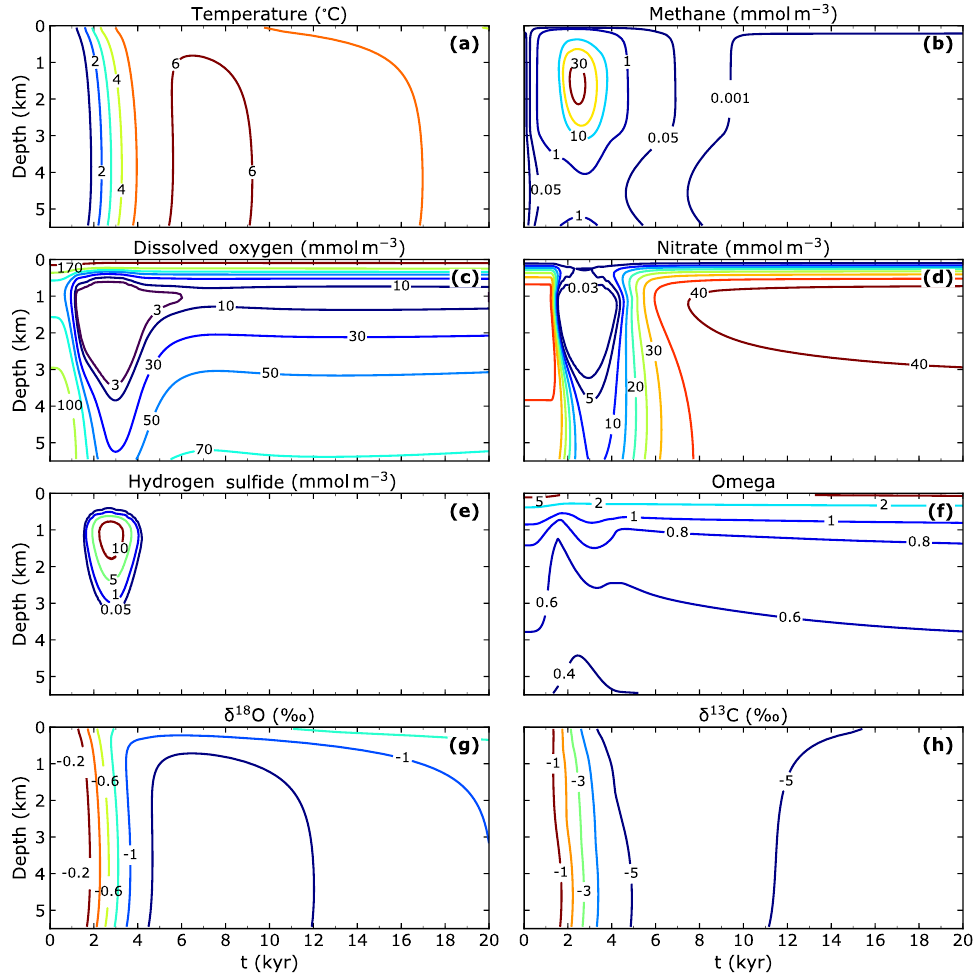
Figure 11. LL ocean property results as functions of water depth and time for a 20000-year simulation with a methane input of 6000GtC over a timescale of 3000 years, all of which dissolves in the ocean. (a) Temperature anomaly, (b) methane concentration, (c) dissolved oxygen concentration (model denitrification for O 2 < 3mmolm − 3 ), (d) nitrate concentration (model sulfate reduction for NO 3 < 0 . 03mmolm − 3 ), (e) hydrogen sulfide concentration, (f) omega, the ratio of carbonate ion concentration to the carbonate ion saturation concentration for calcite (see Fig. 11g), (g) oxygen isotope excursion in biogenic carbonate produced in situ. (h) Carbon isotope excursion. No corrections for